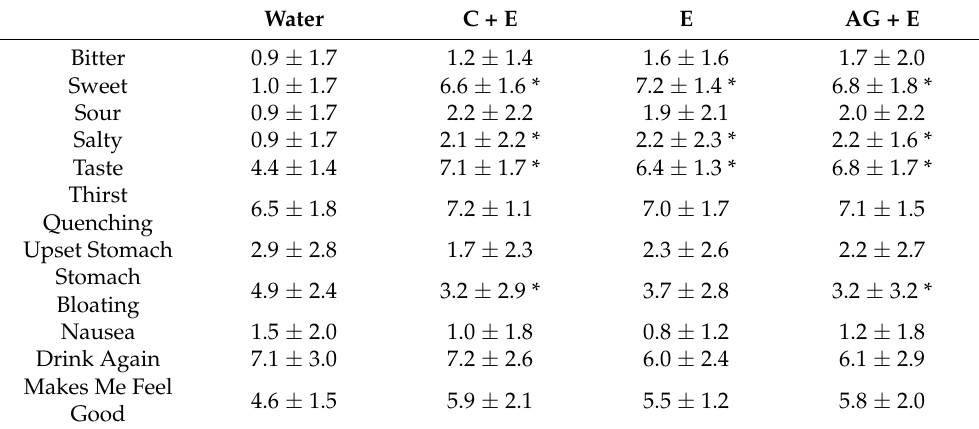
Table 4. Mean ( ± SD) beverage palatability, tolerance, and acceptability ratings on 10 cm visual analog